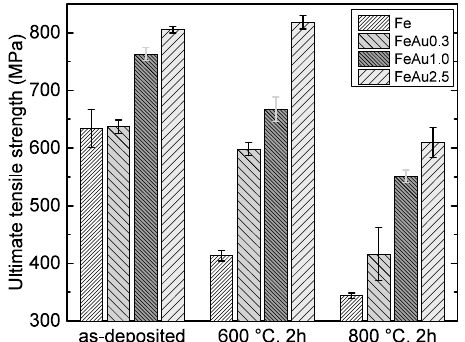
Figure 1. Ultimate tensile strength of the Fe, FeAu0.3, FeAu1.0 and FeAu2.5 samples, before and after different heat treatments.